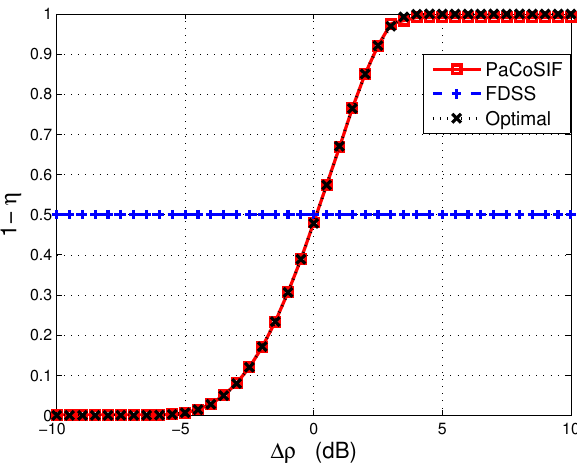
Figure 7. The exponent assigned to the SU-Rx in spectrum-heterogeneous